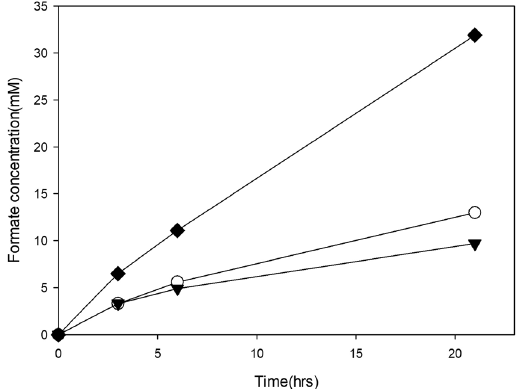
Figure 6. The comparison between formate production of wild type and that of mutant (F1A-P1) cultured under optimum conditions: WT cultured in basic conditions (0.5% (v/v) MeOH, 1x tungstate(30 μ M)) ( ○ ), WT cultured in optimum conditions (2.0% (v/v) MeOH, 2x tungstate(60 μ M)) ( ▼ ), F1A-P1 cultured in optimum conditions (2.0% (v/v) MeOH, 2x tungstate(60 μ M)) (0.6 g wet-cell, 10 mM MV, pH 6.0; CO 2 gas purging (99.999%, rate: 1 mL/s)) ( ⬥